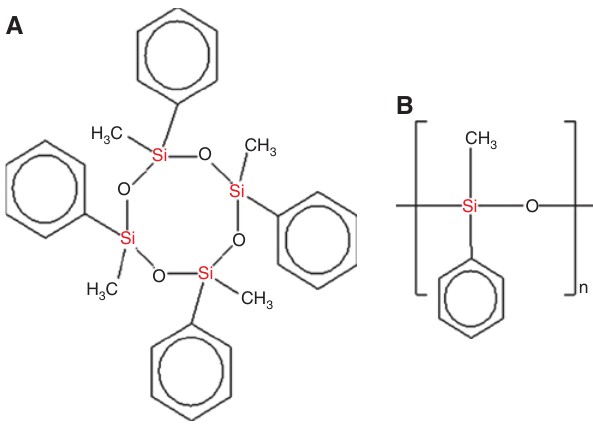
Scheme 1: The structure of (A) tetraphenyltetramethylcyclotetrasi- loxane (D 4Ph,Me ) and (B)